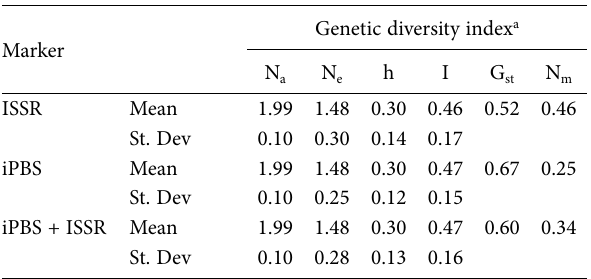
Table 3. Summary of genetic diversity indices analysed in popula- tions of